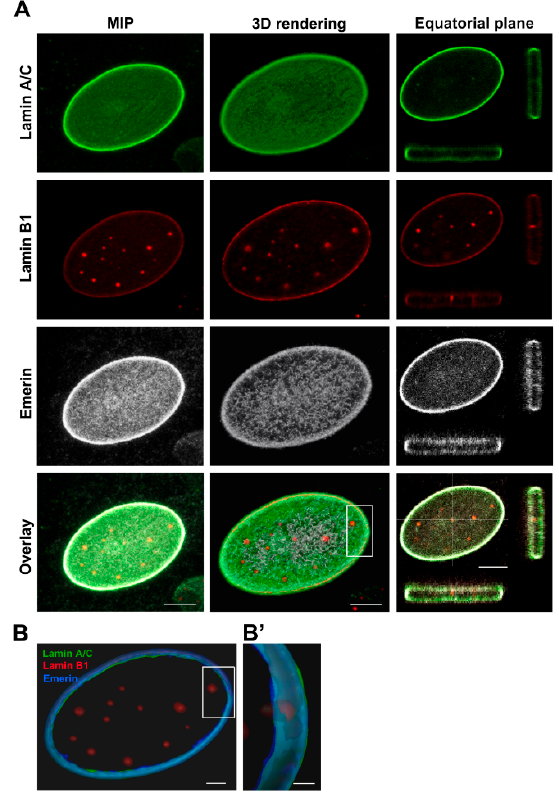
Figure 2. Confocal imaging of co-distribution of A / C and B1 lamins and emerin in osteoblasts. ( A ) Maximum intensity projection (MIP) of series of z-stacks images covering the entire nucleus (left column), 3D rendering in blend volume mode (central column, LAS X 3D software, Leica Microsystems, Wetzlar, Germany), and XZ- and YZ-axes projections performed in the central focal plane of the nucleus (right column) are shown. Bars: 5 µ m. ( B ) 3D rendering in the focal central plans of the nuclear rim in surface volume mode (Imaris software). ( B’ ) High magnification of the 3D rendering of the boxed area showing the di ff erential expression of lamins (in green and red) and emerin (pseudocoloured in blue). Bars: 1 µ m.